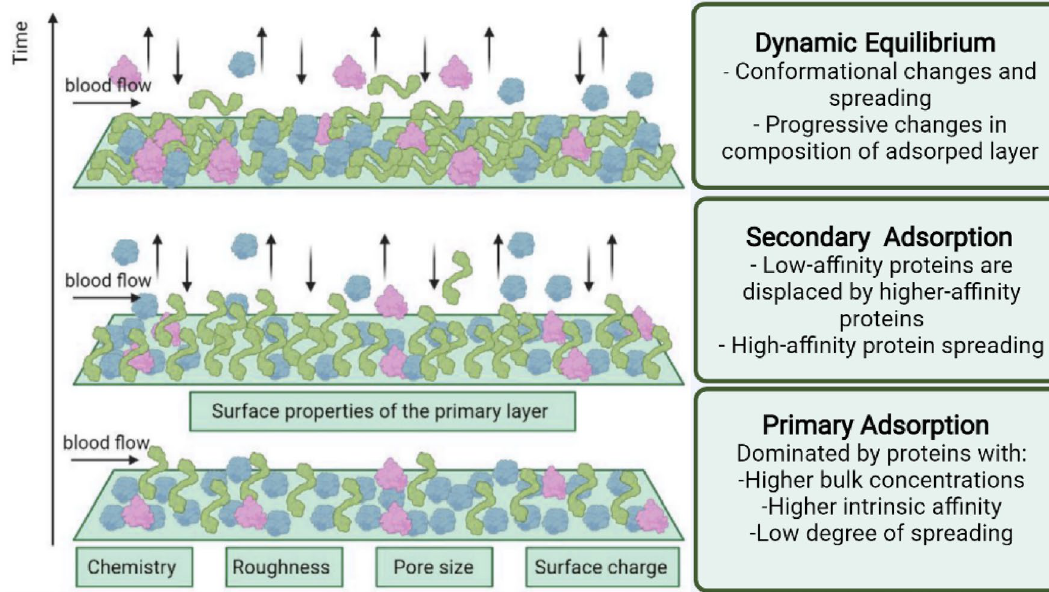
Figure 1. Illustration of competitive human serum protein adsorption and Vroman effect on dialysis membrane.